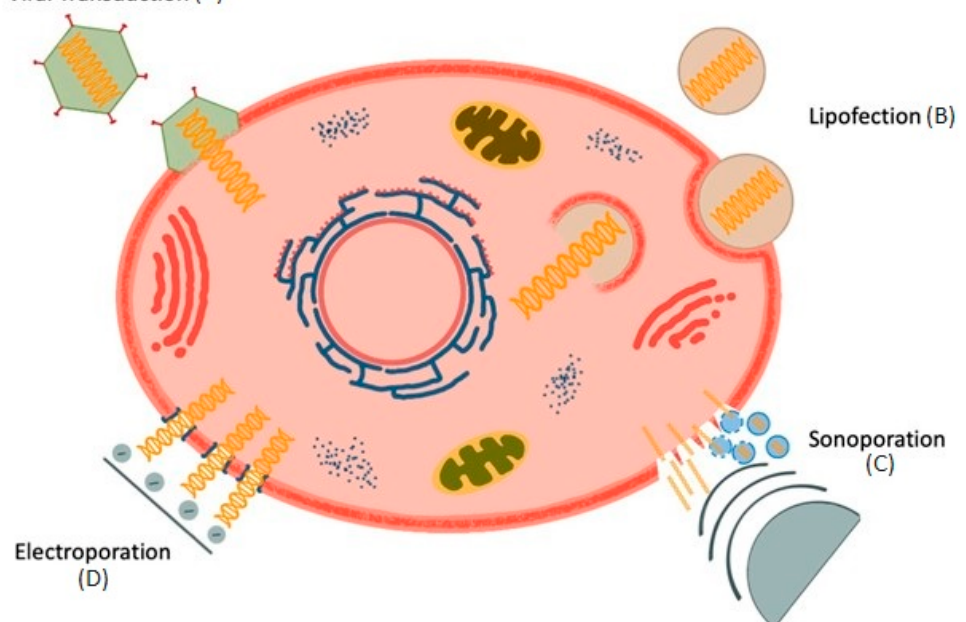
Figure 1. Gene therapy techniques. ( A ) Transduction uses a vector to deliver genetic material into the cell. ( B ) Lipofection: Liposomes become incorporated by the cell and releases genetic material after destruction of the endosome membrane ( C ) Sonoporation: Genetic information gets channeled either directly by ultrasound or via bursting microbubbles ( D ) Electroporation brings genetic material via electrically conductive pores into the cell.